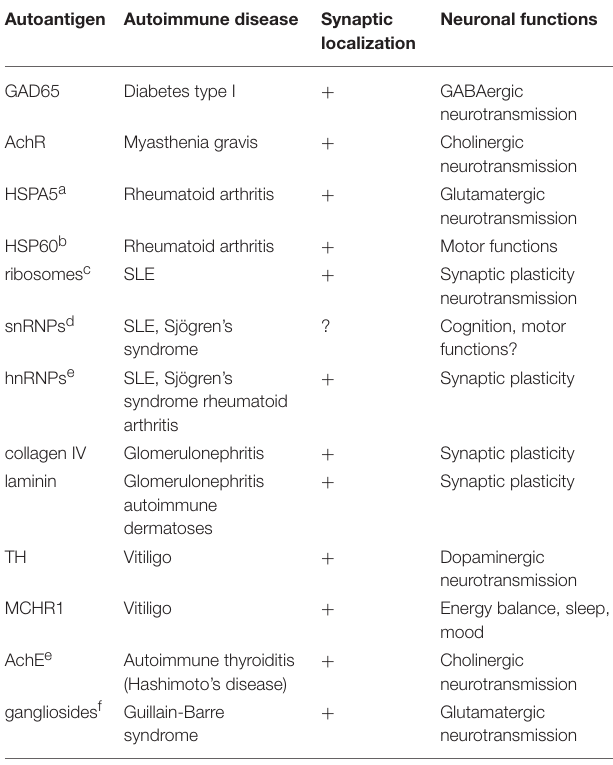
TABLE 3 | Major autoantigens targeted in non-CNS organ-specifc autoimmune disorders belong to the synaptic